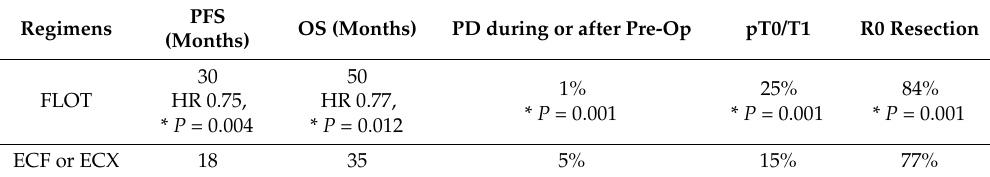
Table 3. Results of peri-operative FLOT in patients with resectable gastric or gastroesophageal junction